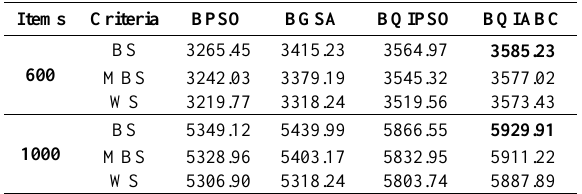
Table 3. Comparison between BQIABC and some binary algorithms using knapsack problems with 600 and 1000 items.